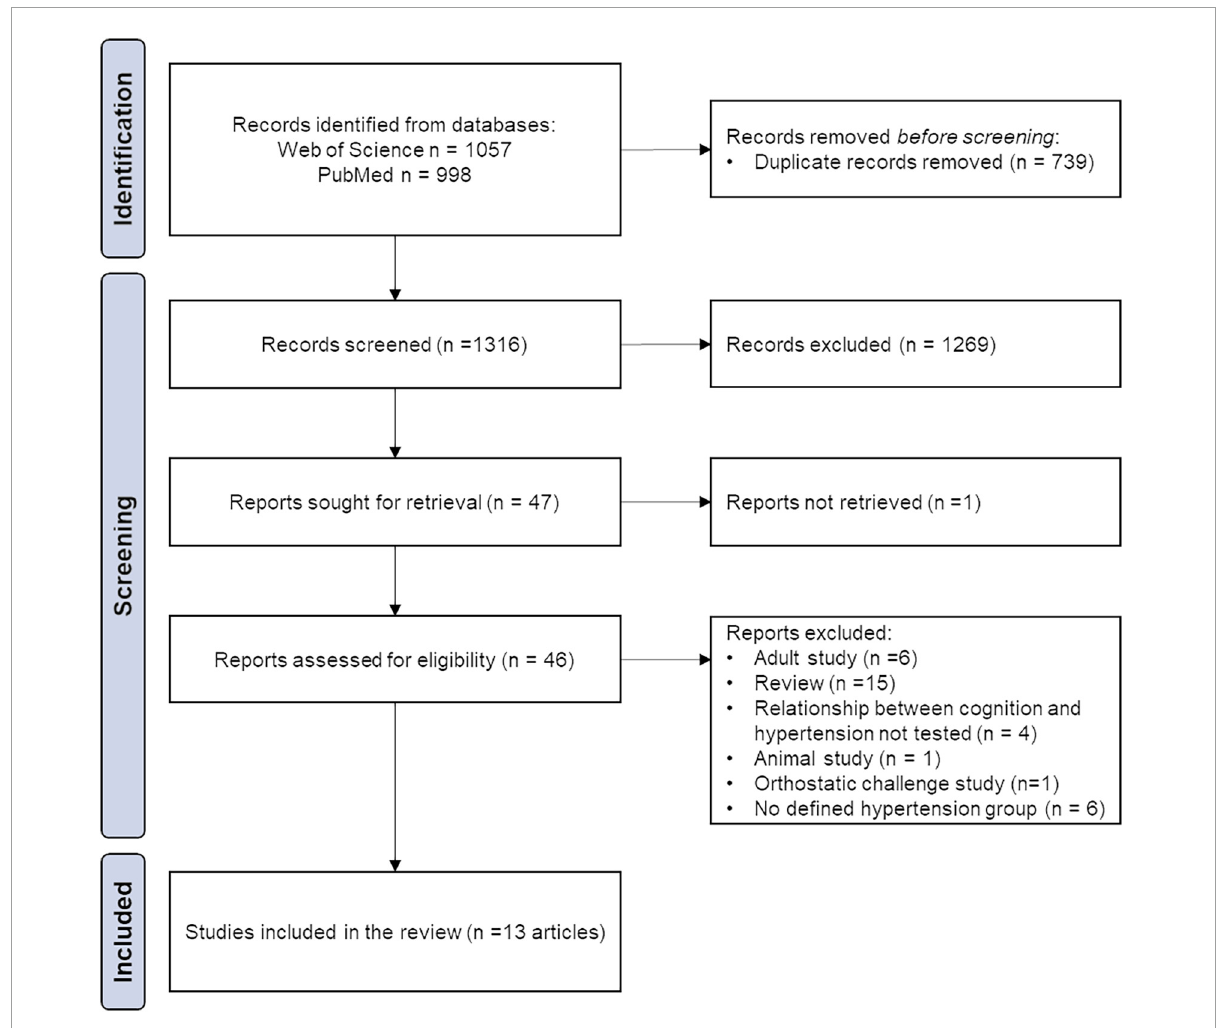
FIGURE1 The article selection procedure, according to the PRISMA